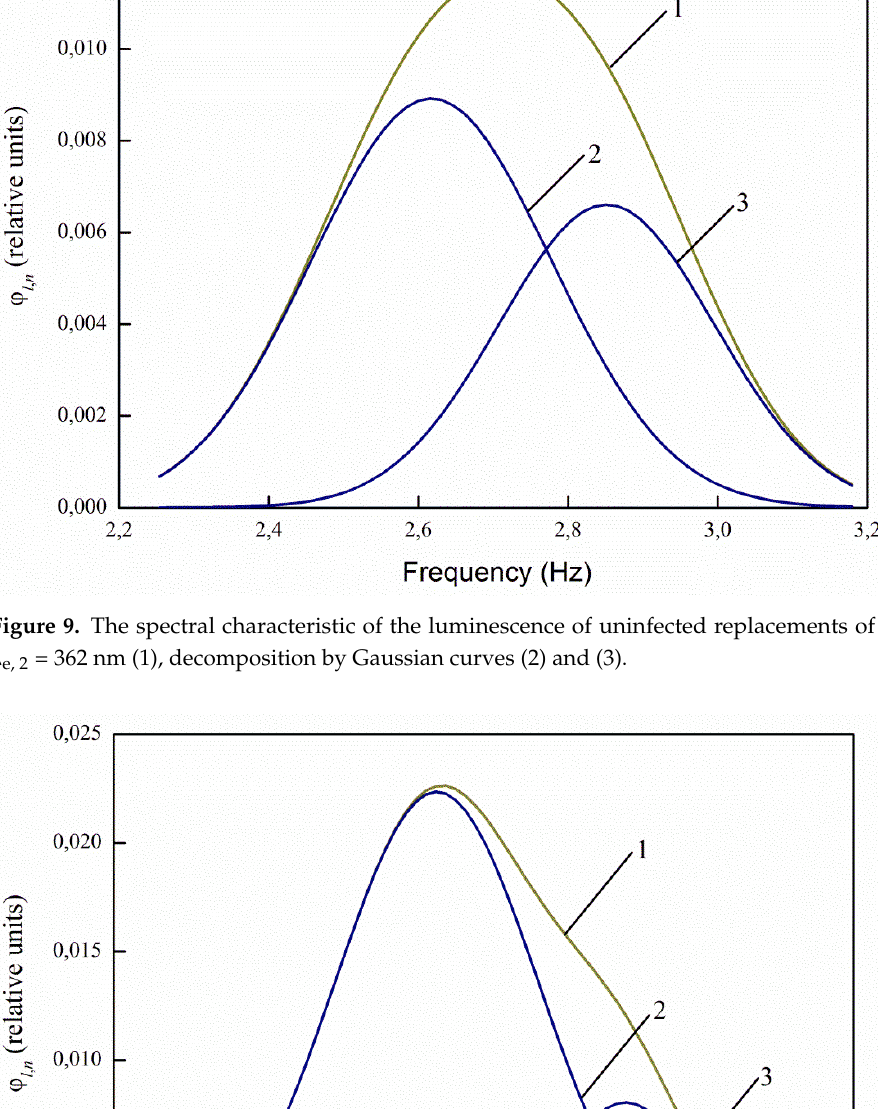
Figure 8. The spectral characteristic of the luminescence of uninfected replacements of wheat at λ e, 1 = 232 nm (1), decomposition by Gaussian cur ves (2) and (3), where φ l,n is the normalized photolu- minescence intensity.